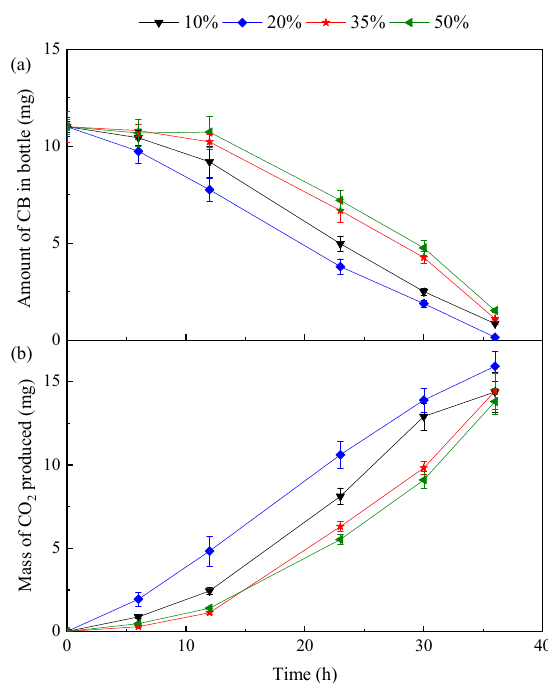
Figure 2. ( a ) CB biodegradation and ( b ) CO 2 production profiles of the biphasic system with different volume fractions of silicone oil. The initial CB addition was 11 mg in each test bottle.